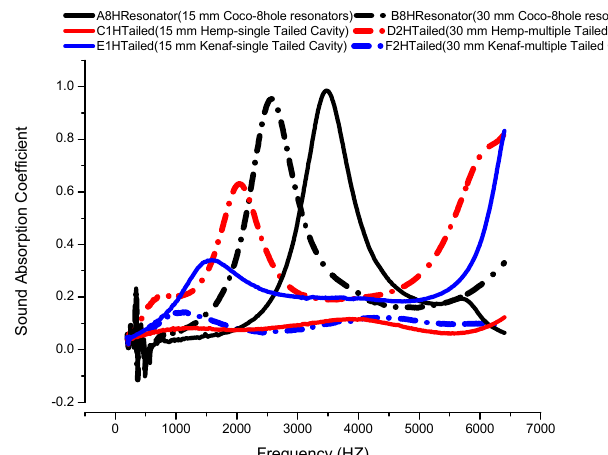
Figure 6. Absorption Comparison of coco-husk fiber with wavelength resonator and Hemp-Kenaf with Tailed Cavity inclusion.